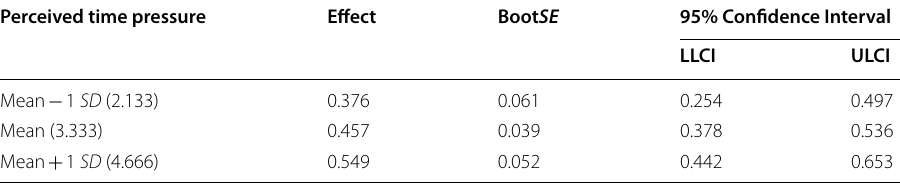
LLCI lower bound confidence interval, ULCI upper bound confidence interval